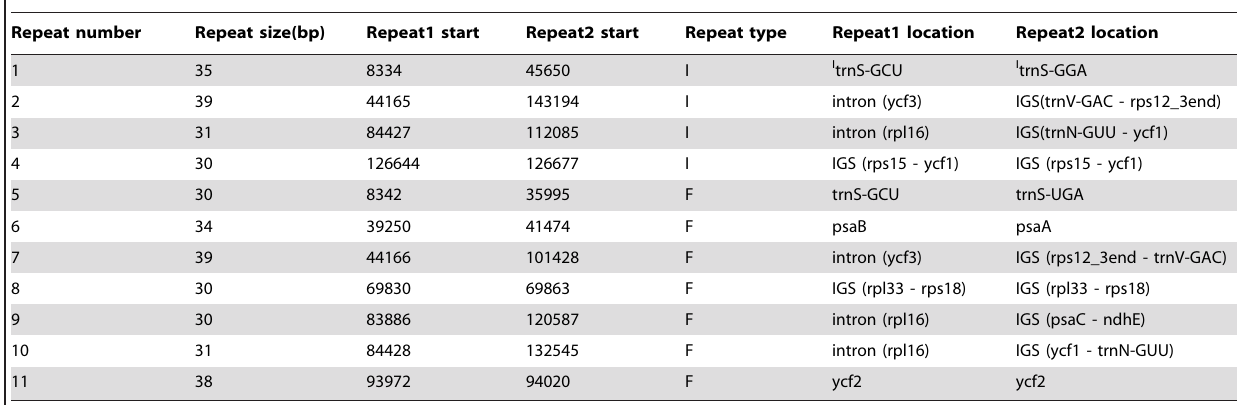
Table 2. Repeated sequences in the date palm chloroplast genome.